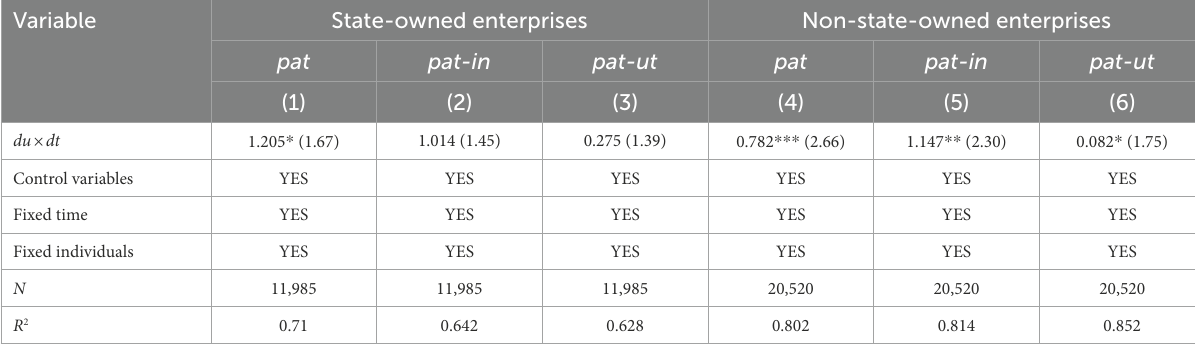
TABLE 5 Results of the heterogeneity test of enterprise